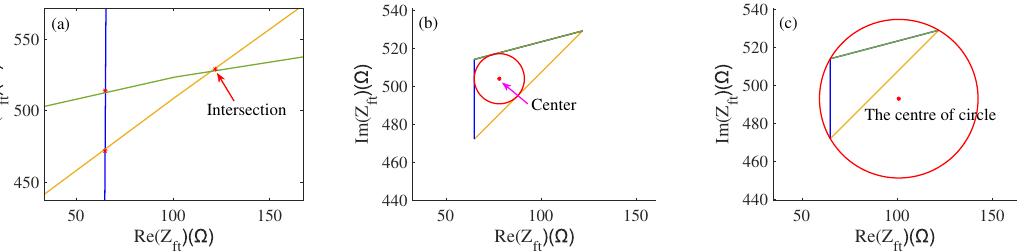
Figure 13. ( a ) Mapping curve intersection diagram; ( b ) Inscribed circle diagram; ( c ) Circumcircle diagram.